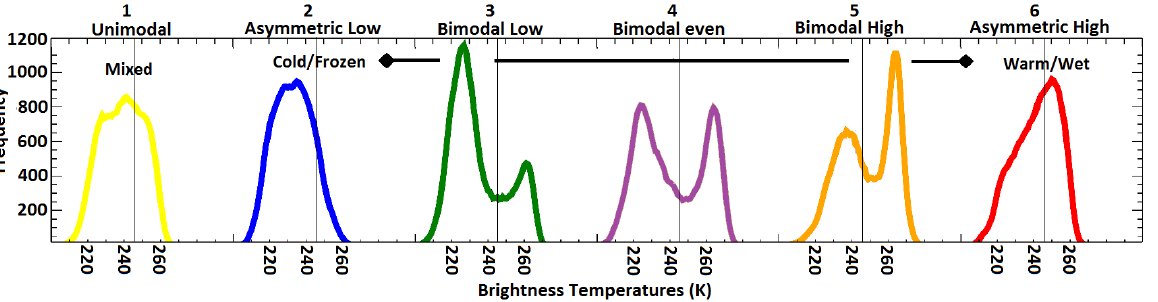
Figure 1. Generalization of melt regime pattern determined from the sum of annual brightness temperature histograms. Warm/wet pixels exhibit an asymmetric high distribution skewed to the right (#6; red curve); in contrast, cold/frozen pixels exhibit the asymmetric low distribution skewed left (#2; blue curve). Pixels that are cold/frozen a large portion of the year but also have some melt exhibit bimodal low distribution (#3; green curve) while ones that have more days of melt have a bimodal high distribution (#5; orange curve). Equal time cold/frozen and warm/wet are evenly bimodal (#4; purple curve). Pixels with mixed or water signals usually close to the coast are unimodal (#1; yellow curve). The thin vertical line is the melt threshold for this sensor and wavelength (246 K) determined from previous work [20] and (in conjunction with diurnal amplitude variations, DAV) indicates when the surface starts